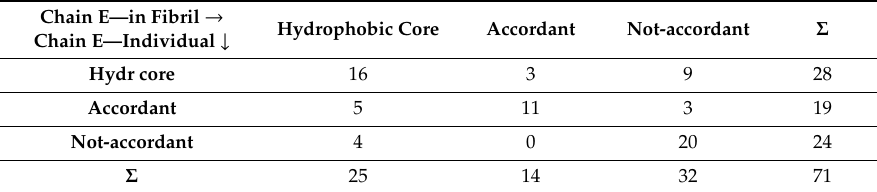
Table 4. Status (number) of residues involved in the construction of the hydrophobic core, showing the status in accordance with the fuzzy oil drop model and incompatible with the fuzzy oil drop model. The columns express the status in chain E in as a fibril component, rows—status in an individual chain. Chain E—in Fibril → Chain E—Individual